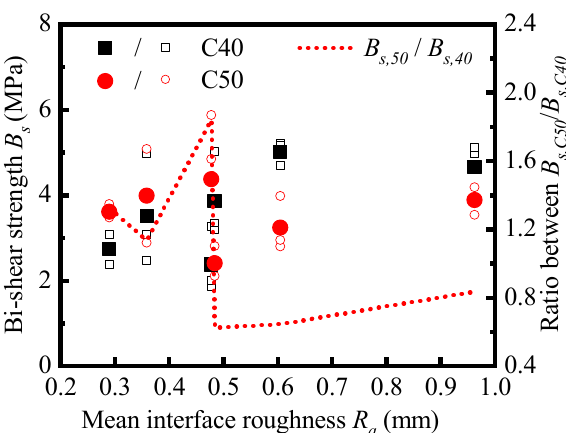
0.2 0.3 0.4 0.5 0.6 0.7 0.8 0.9 Figure 13. Relationship between bi-shear strength and interface roughness R a Figure 13. Relationship between bi-shear strength and interface roughness R a .